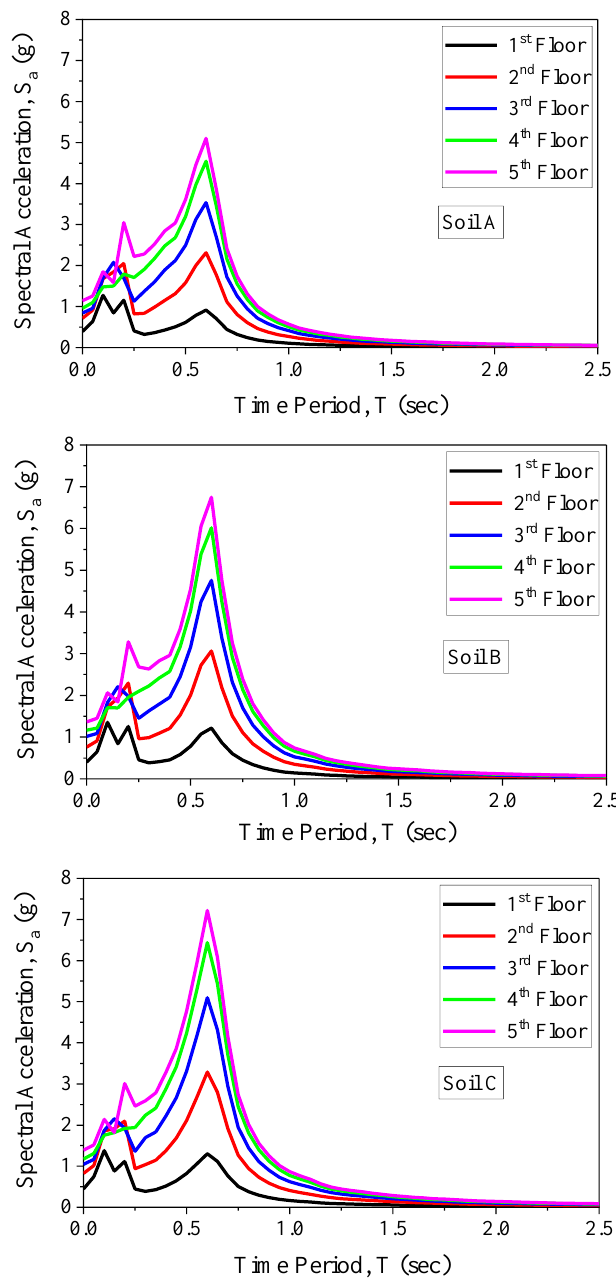
Figure 5. FRS of a regular building for various soil types.